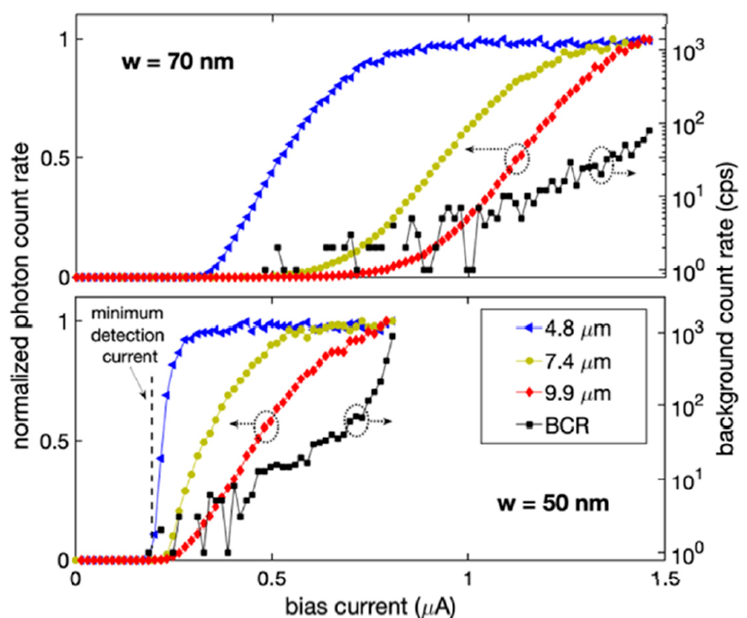
Figure 4. Normalized photon count rate vs. bias current curves for SNSPDs fabricated from a WSi film with silicon content of 48 ± 10%. Two different nanowire widths (50 and 70 nm) are presented, and measurements were obtained at three wavelengths (4.8, 7.4, and 9.9 µm) at an operating temperature of 0.85 K. Black squares correspond to the measurement of the background count rates. Adapted and reproduced from [48], with the permission of AIP Publishing, copyright 2021.